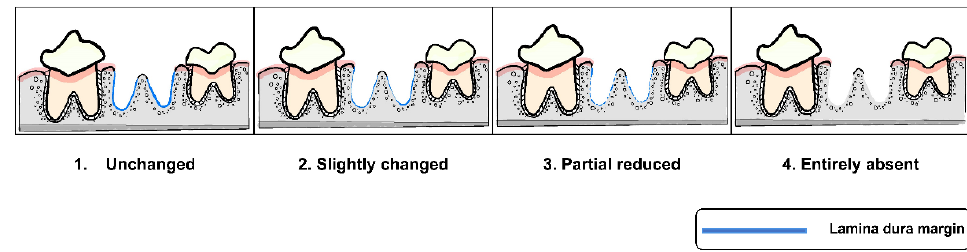
Figure 2. Characteristics of surgical site margin of post-extraction sockets in four grades (Criteria A).